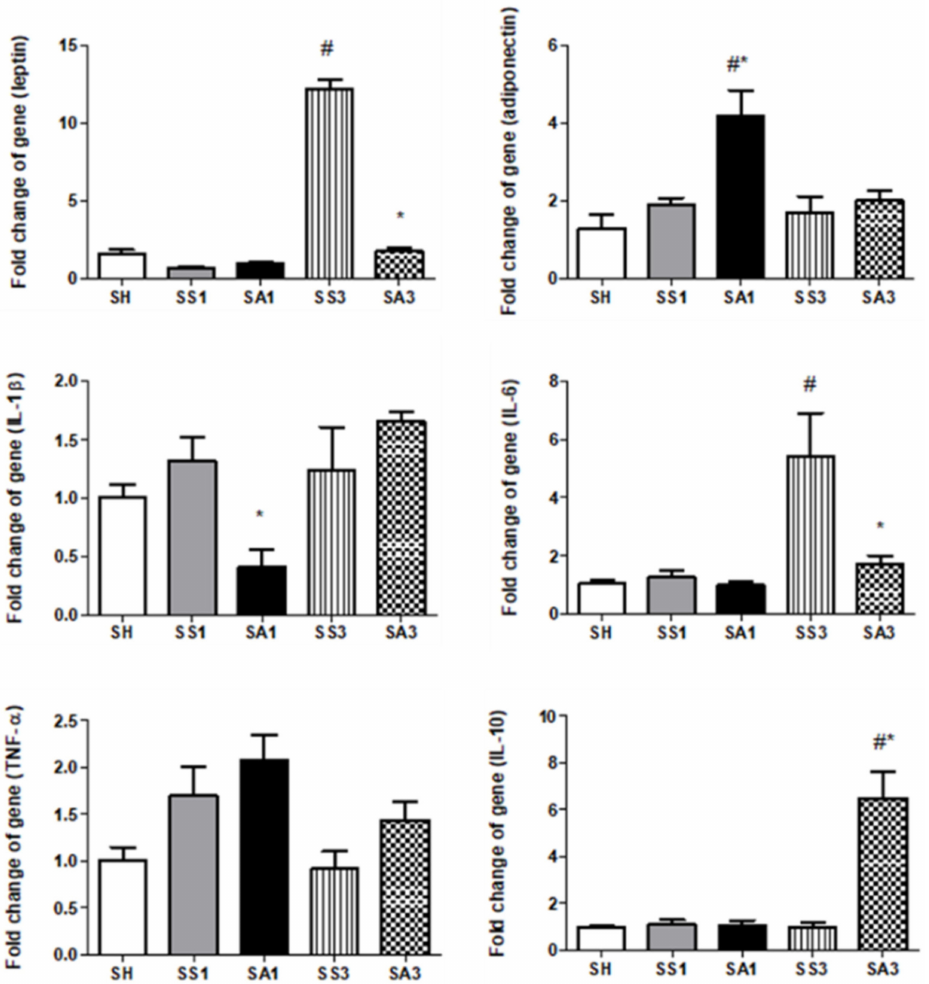
Figure 5. Messenger RNA expressions of pro- and anti-inflammatory mediators in epididymal fat tissues. IL, interleukin; TNF, tumor necrosis factor; SH, sham group without a sleeve gastrectomy (SG) ( n = 8); SS1 and SS3, saline groups sacrificed on day 1 or 3 after the SG; SA1 and SA3, arginine groups sacrificed on day 1 or 3 after the SG. n = 10 for each SG group. Values are presented as the mean ± SEM. A two-way analysis of variance (ANOVA) with the Bonferroni post-hoc test was used to analyze differences among the SH and gastrectomy groups. # Significantly differs from the SH group. * Significantly differs from the SS group at the same time point ( p <